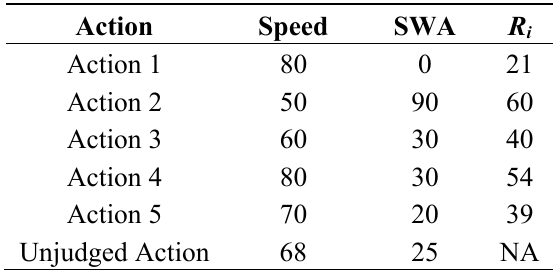
Table 1. Five judged actions and a new action whose judgment is not available (NA) in advance and has been